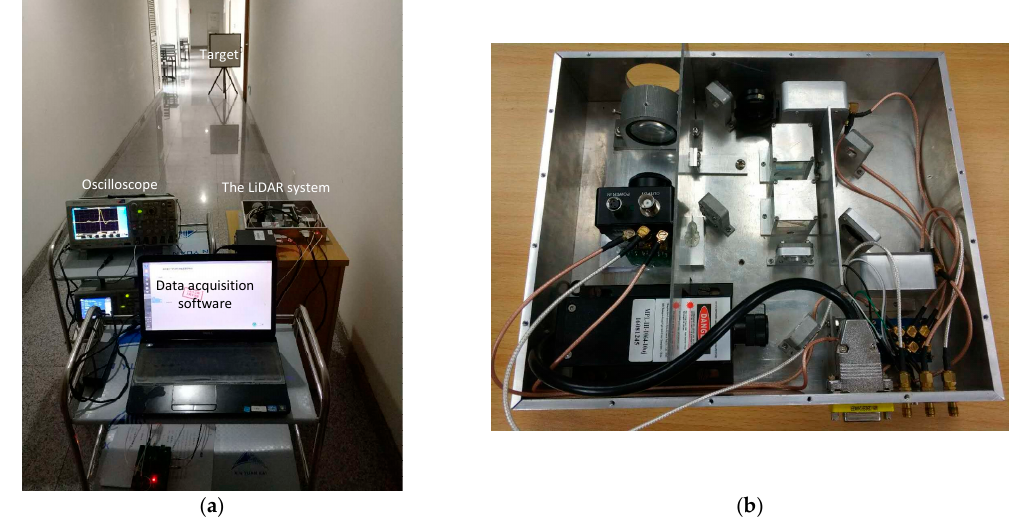
Figure 11. Experiment scene of LiDAR ranging and waveform recording. ( a ) The acquisition software and oscilloscope are used to gather the data. ( b ) The enlarged LiDAR system.